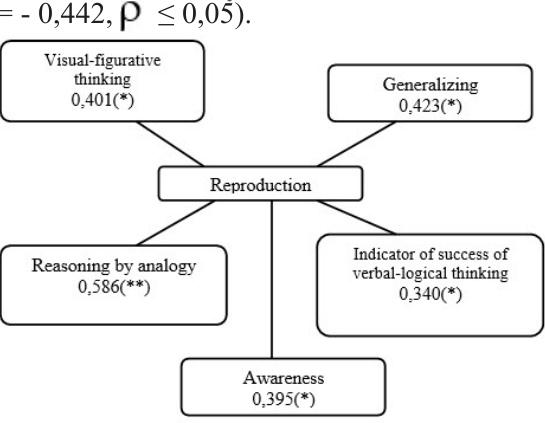
Figure 9 . The correlation of reproduc- tion and indicators of thinking in children of